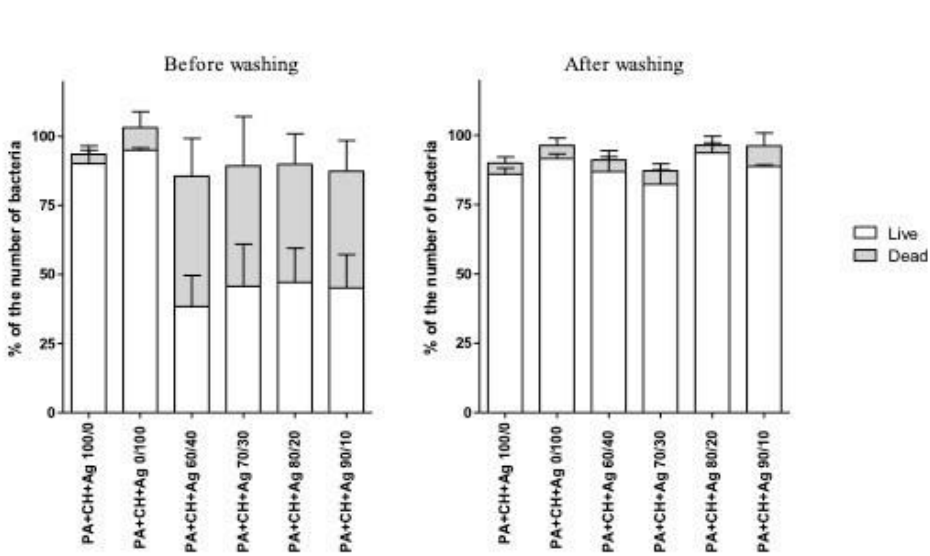
Figure 6. Antimicrobial response of Staphylococcus aureus ( A ) and Pseudomonas aeruginosa ( B ) to different combinations of chitosan (CH) and silver nanoparticles (Ag), before and after washing of the nylon fabrics (PA). The dilutions are represented as the percentage of chitosan and silver (CH/Ag), where the sample PA + CH + Ag 100/0 represents the control only with chitosan and the PA + CH + Ag 0/100 represents the control only with